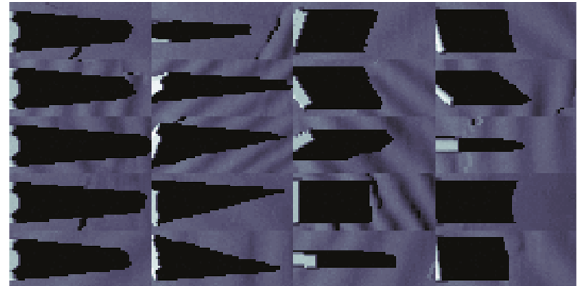
Figure 14: Snapshot of the shadow of the four targets (from left to right: Manta, Rockan, Cube and Cylinder) to classify with di ff erent orientations and backgrounds. The pixel size is these target images is 5 cm. The size of each snapshot is 1.25m × 2.75 m.